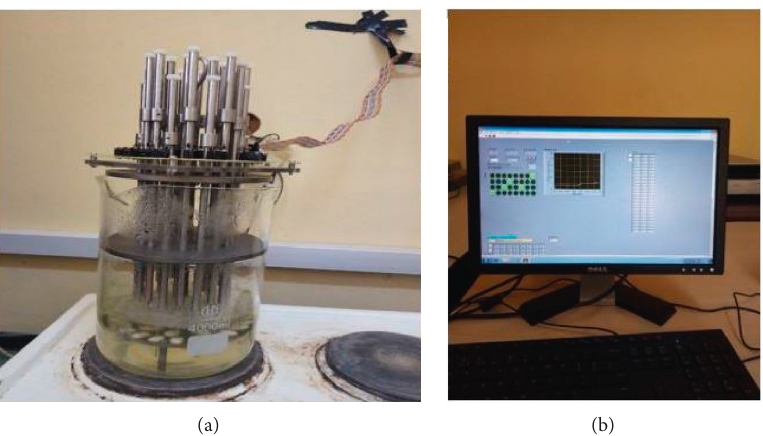
Figure 1: Schematic representation of automated Mattson bean cooker used in the present study: (a) shows the plungers, beaker, and the cooker and (b) shows the computer set